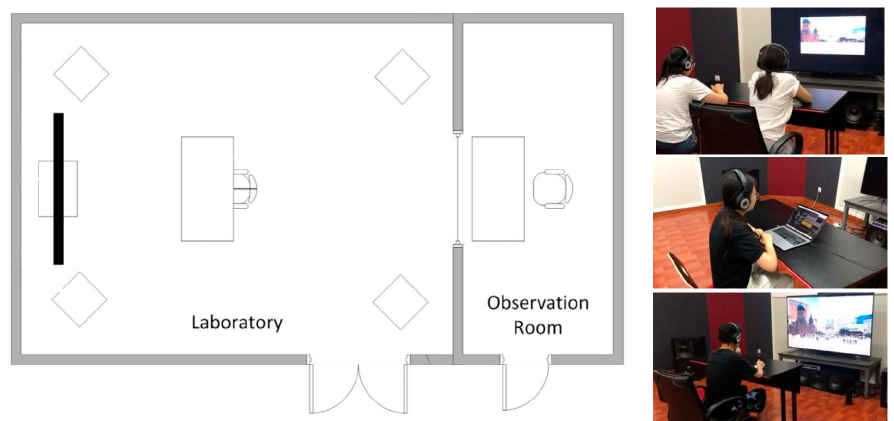
Figure 1. Laboratory layout schematic.